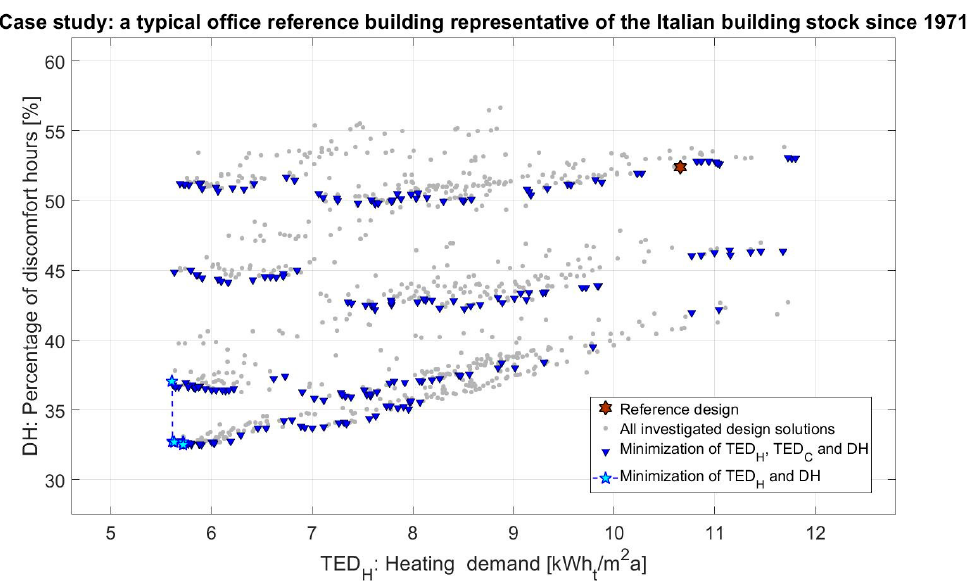
Figure 9. 2D Pareto front TED heat –DH.